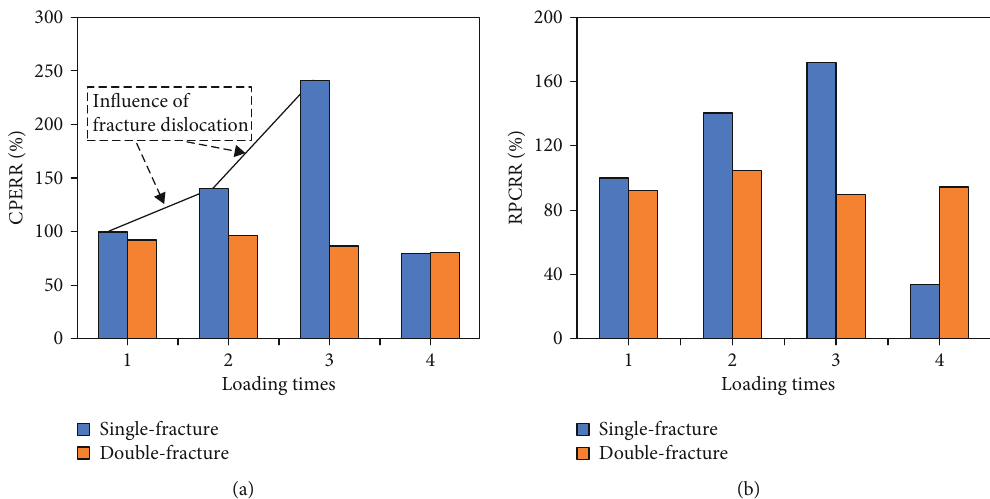
Figure 12: The permeability enhancement reduction at di ff erent loading stages (at 108 MPa): (a) cumulative permeability enhancement reduction rate; (b) relative permeability enhancement reduction